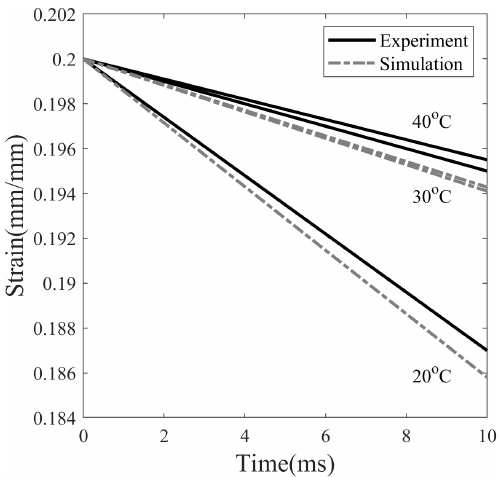
Figure 12. Instantaneous strain recovery of SMP at three different programming temperatures: 20, 30, and 40 °C due to